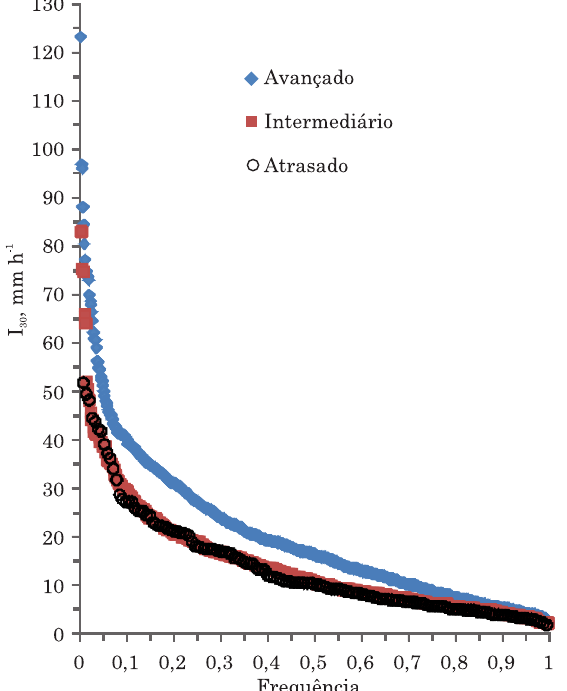
Figura 1. Frequência das intensidades máximas em 30 min (I 30 ) das chuvas erosivas de Urussanga, SC, segundo padrão de distribuição